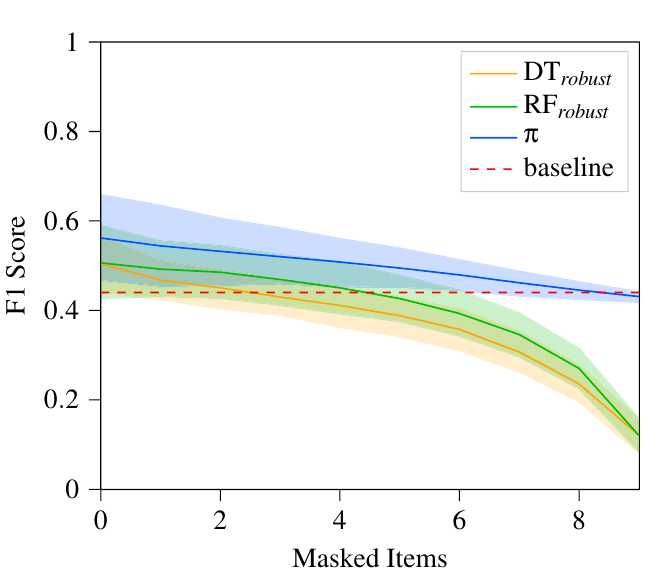
Figure 4. F1-Score degradation as more features are masked from the inputs.